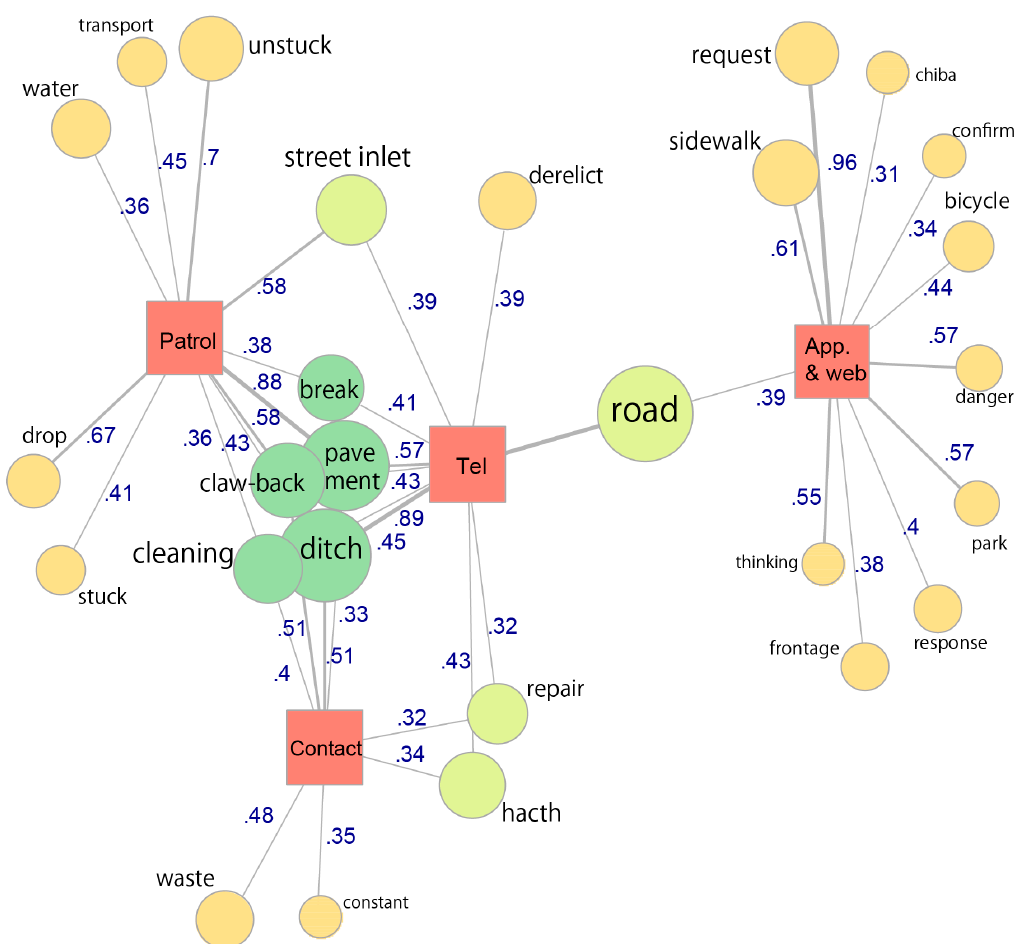
Figure 11. Text mining of reports using the KH Coder co-occurrence network.